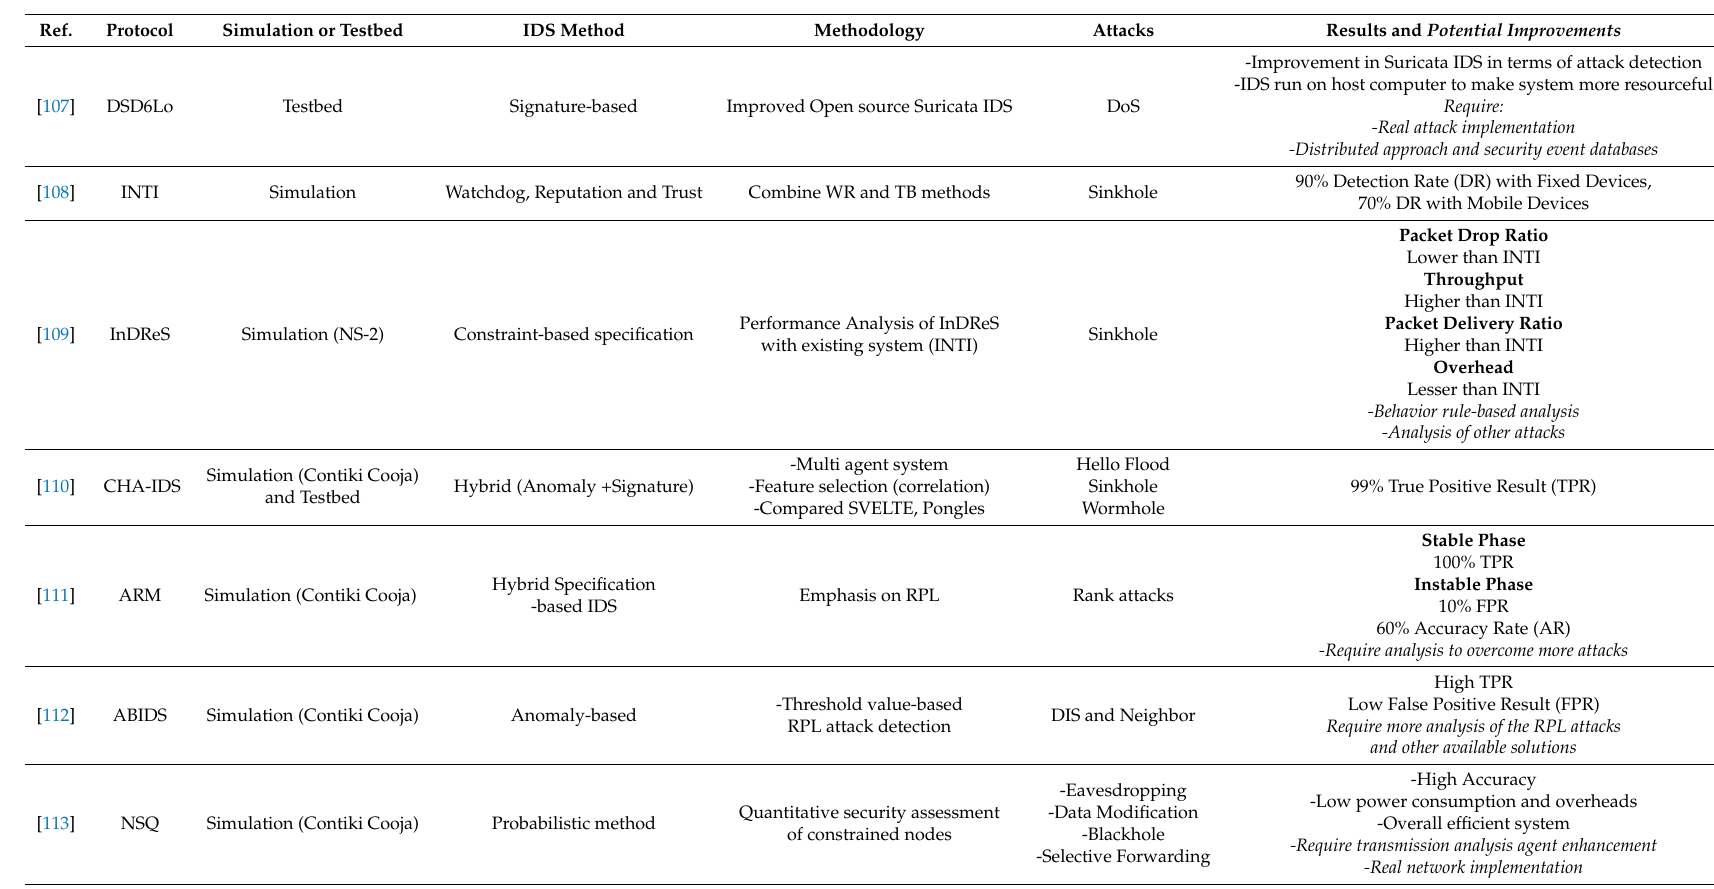
Table 5. Summary of IDS for 6LoWPAN